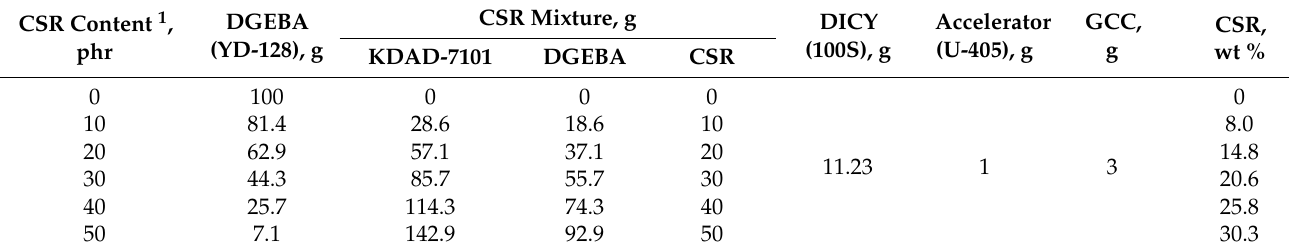
Table 2. Composition of the core-shell rubber (CSR)/epoxy polymer structural